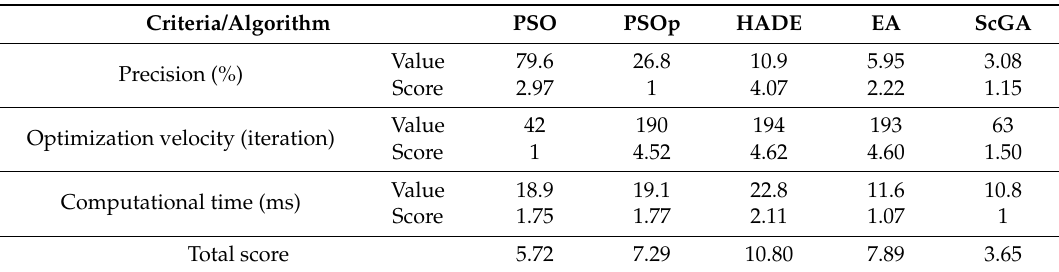
Table 2. OA Comparison.